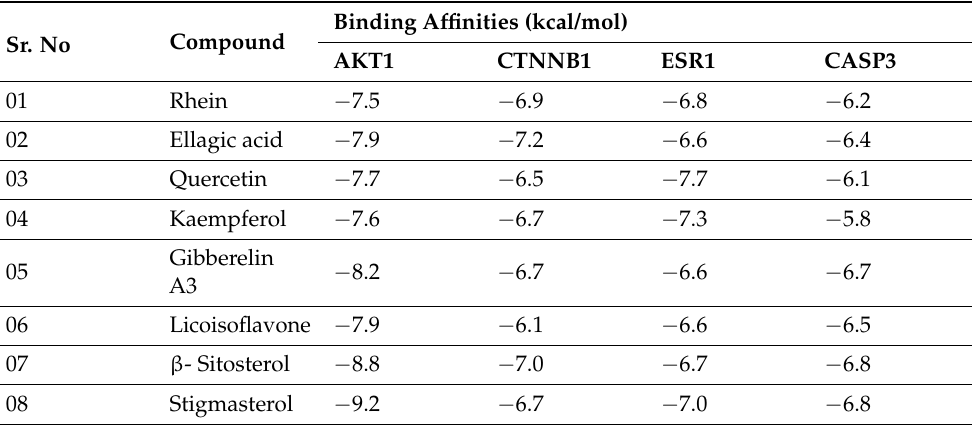
Table 3. The binding affinities of prospective target genes with phytochemicals in the docking